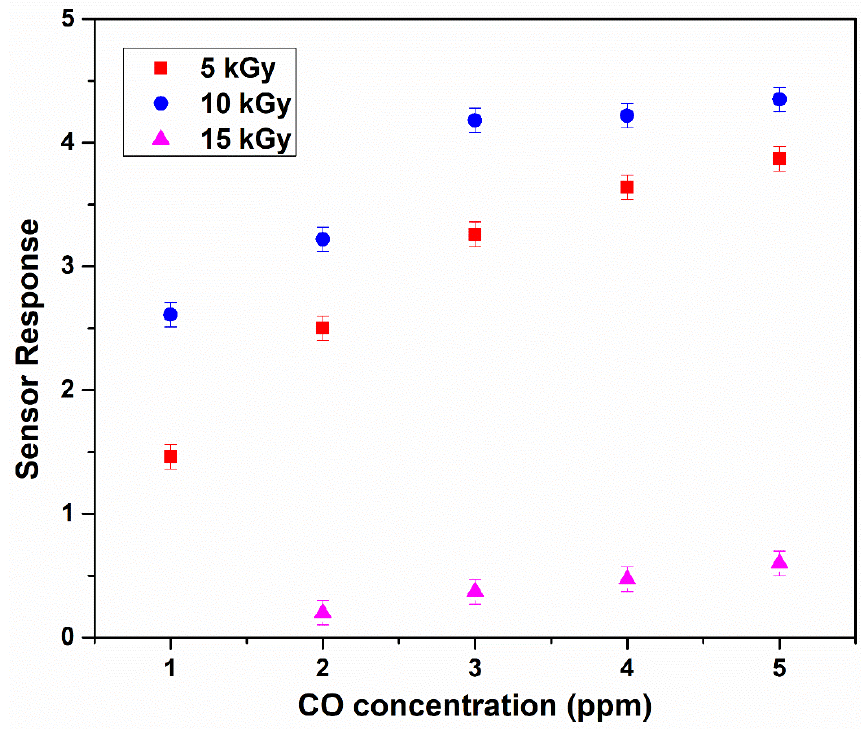
Figure 8. Calibration curve corresponding to Figure 7 (error is ± 0.1).